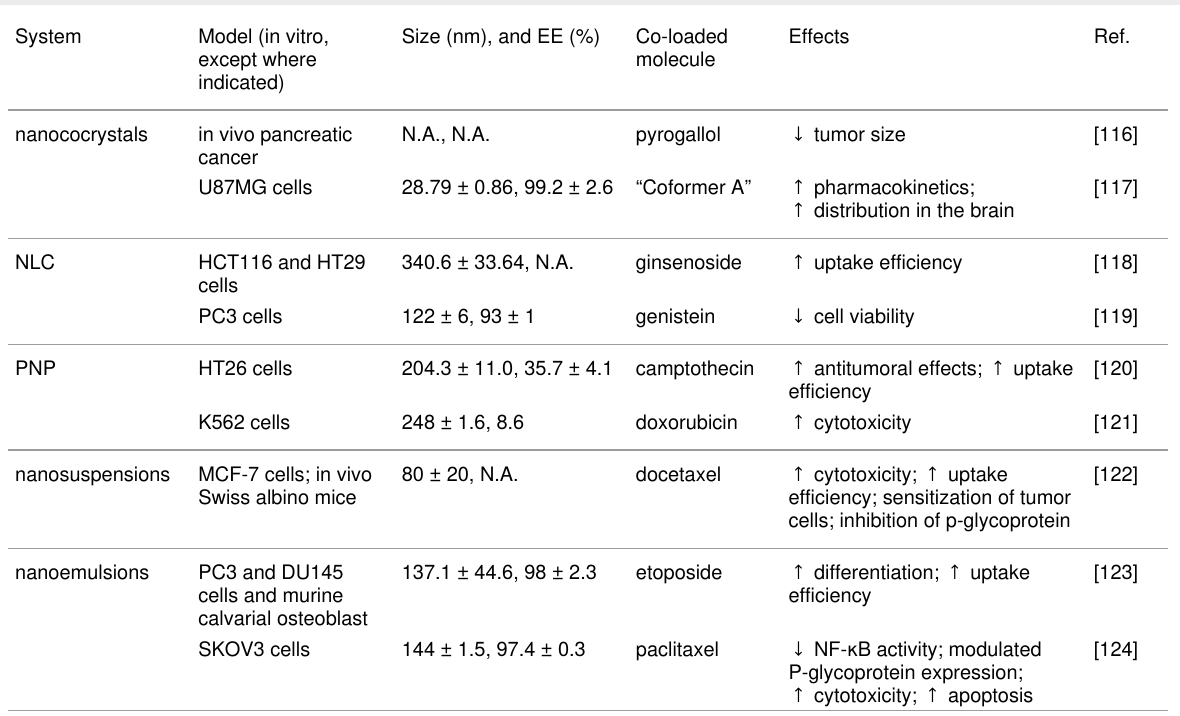
Table 2: CUR co-loaded nanosystems where significant anticancer effects have been reported. System Model (in vitro, Size (nm), and EE (%) Co-loaded Effects except where molecule indicated)